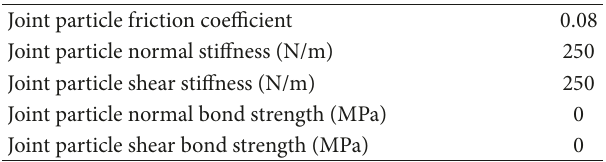
Table 5: Microscopic parameters for joints.